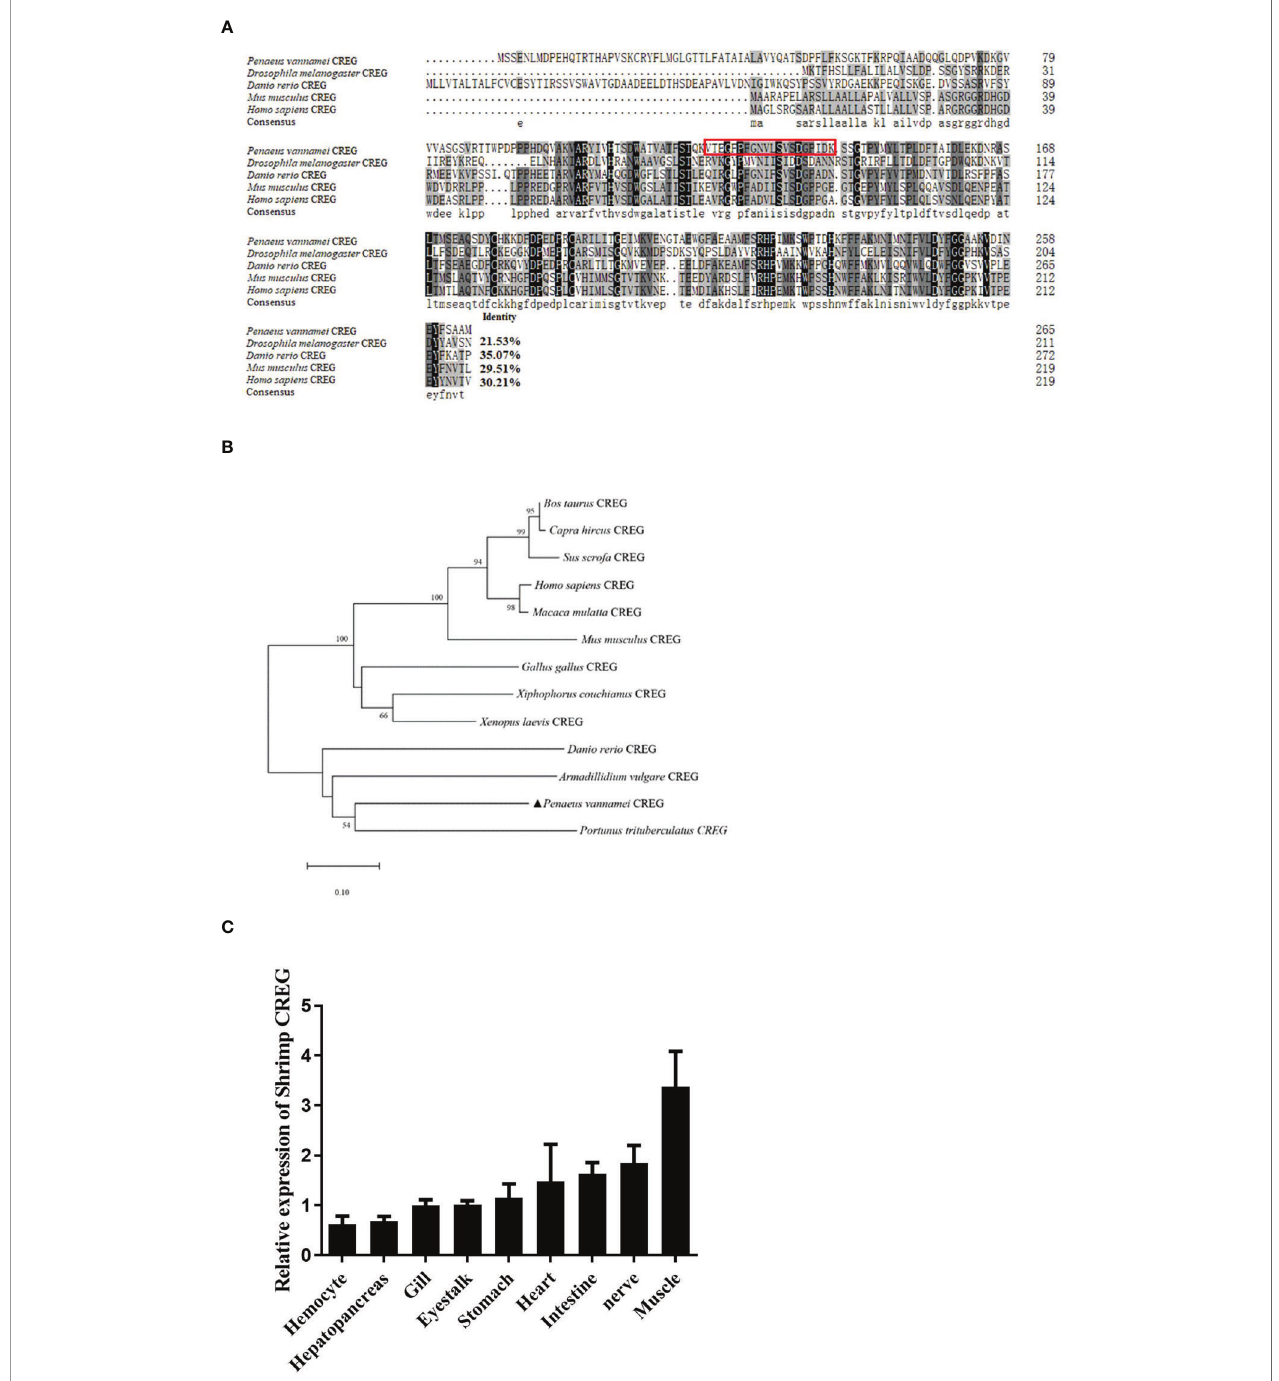
FIGURE 2 | Sequence analyses and tissue distribution of shrimp CREG protein. (A) Multiple sequence alignment between shrimp CREG protein and other CREG proteins. CREG proteins used for the analysis include: Drosophila melanogaster (NP_001247152.1), Danio rerio (NP_001007306.1), Mus musculus (NP_035934.1), and Homo sapiens (NP_003842.1). Identical amino acid residues are shaded in black and similar residues in gray. (B) The neighbor-joining phylogenetic tree based on the sequences of shrimp CREG protein and other known vertebrate and invertebrate CREG proteins. The numbers marked on the tree branches represent the bootstrap values. The location of shrimp CREG protein is indicated by a black- fi lled triangle. (C) Tissue distribution of shrimp CREG protein in shrimps. The expression of shrimp CREG protein was determined relative to PvEF1 a expression, as determined using real-time qPCR